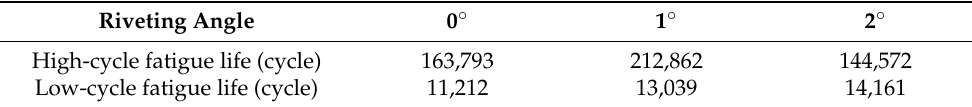
Table 4. Fatigue life of riveted lap joints at different riveting angles.